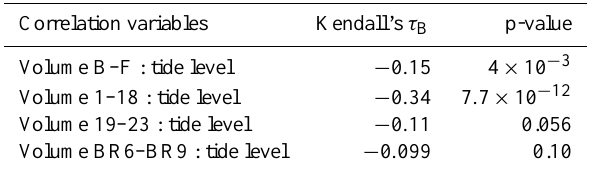
Table 6. Kendall’s τ B correlation coefficients and corresponding p- values between significant wave heights and beach volumes.